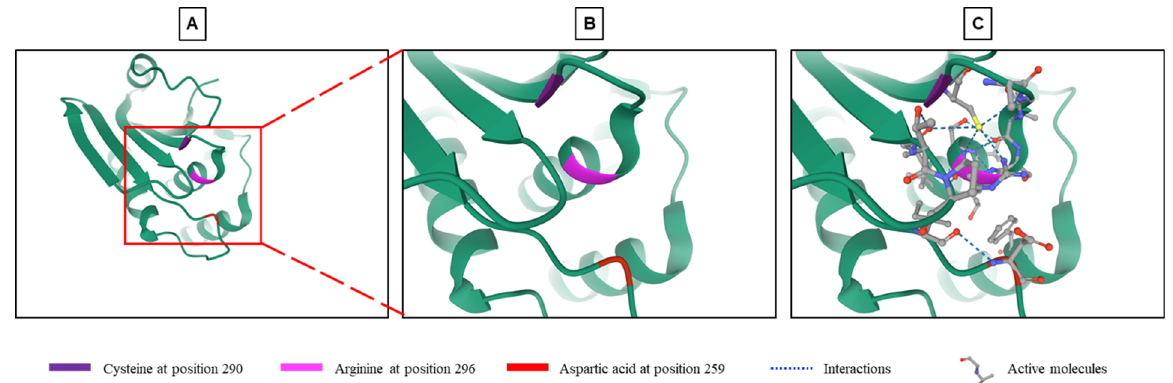
Figure 1. Structure of the phosphatase active site of DUSP9. ( A ) Crystallographic representation of the phosphatase site of DUSP9 with a focus on its catalytic part (see region of interest in red box) composed of a cysteine at position 290, an arginine at position 296 and an aspartic acid at position 259 (from RCSB Protein Data Bank: https://www.rcsb.org/3d-view/3LJ8, accessed on 1 September 2021) [45]. ( B ) Higher magnification of region of interest shown in panel A. ( C ) Same image than in Panel B with inserted substrates and molecular interactions between the three amino acyls and substrate.